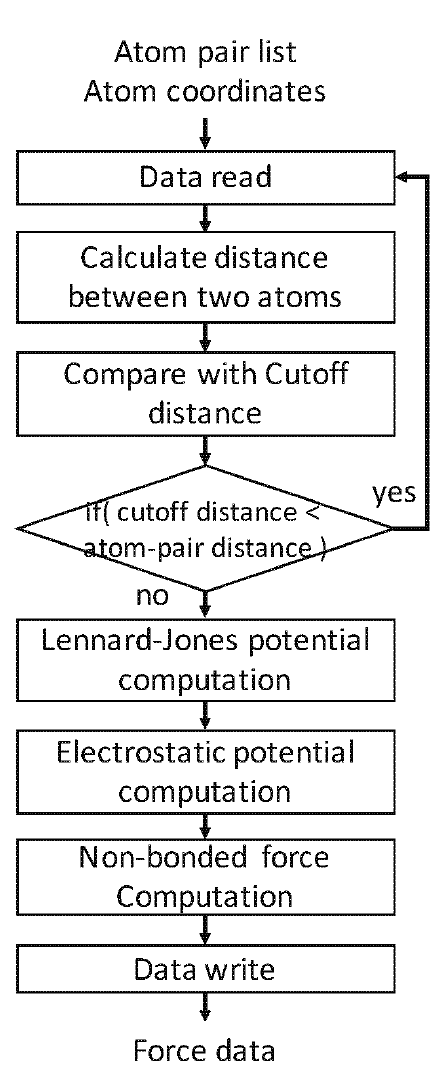
Fig. 7. Flow-chart of the processing in FPGA accelerator.